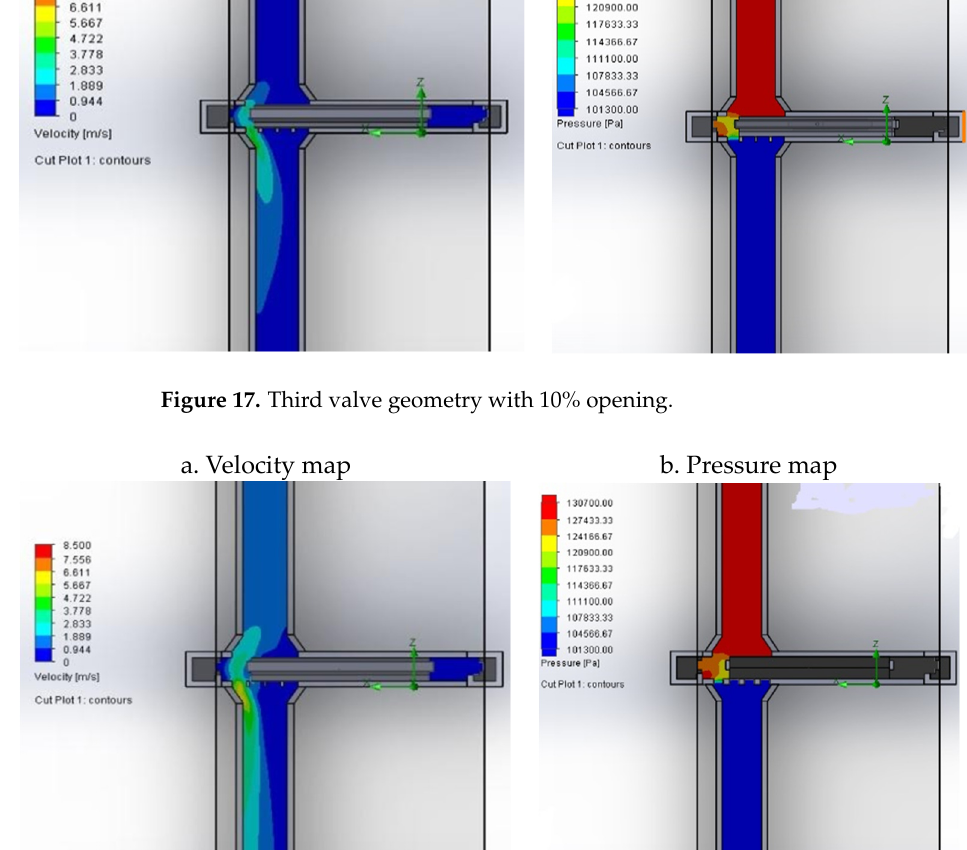
Figure 18. Third valve geometry with 30% opening.